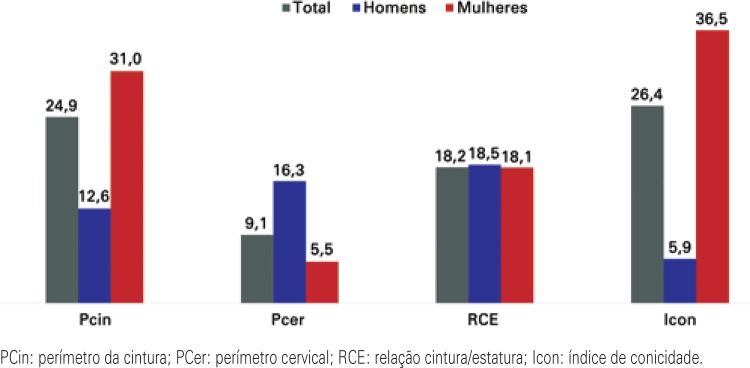
Prevalência de risco aumentado para o desenvolvimento de doença